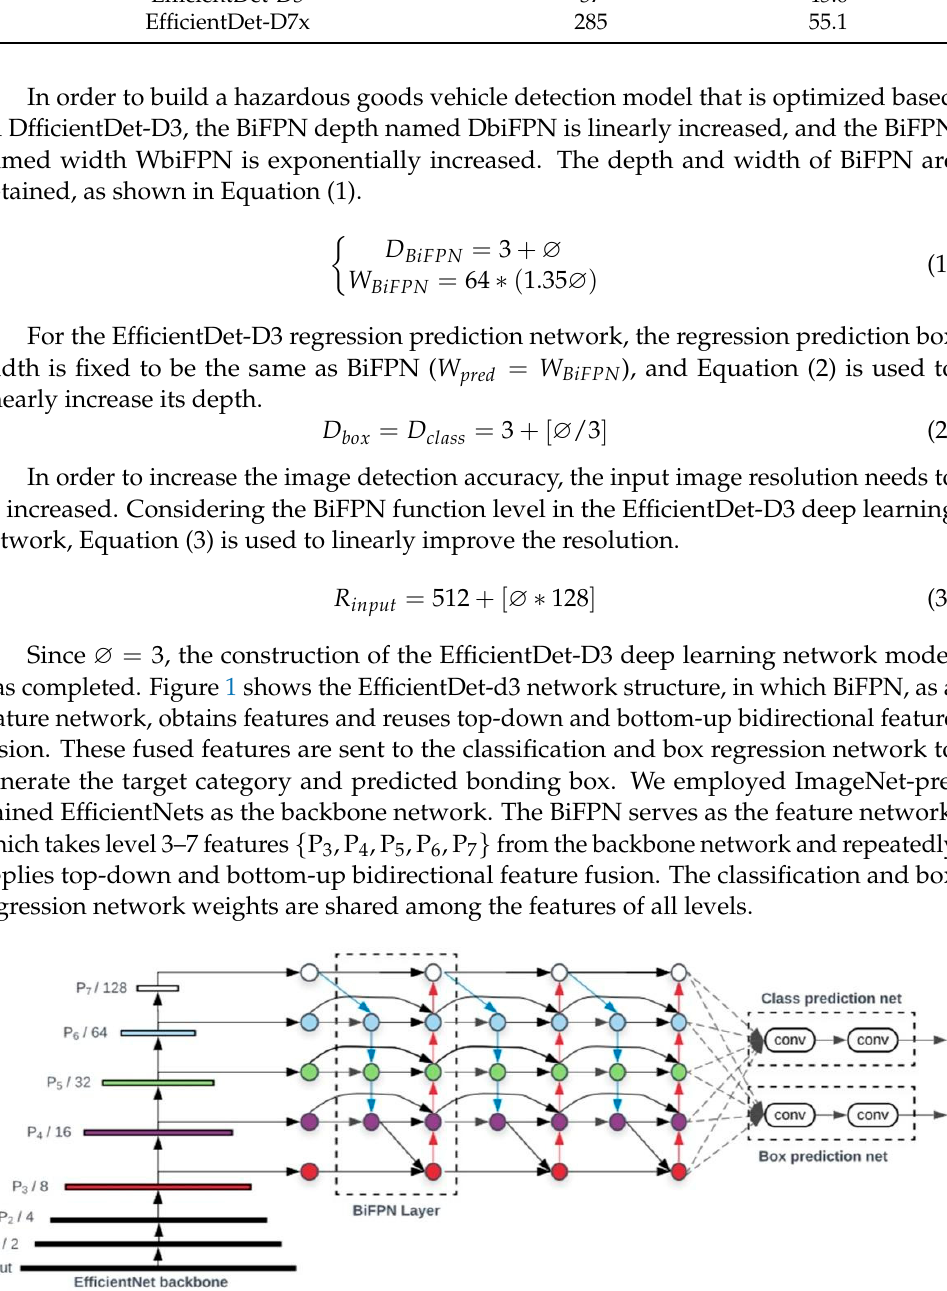
Figure 1. EfficientDet-D3 deep learning network.